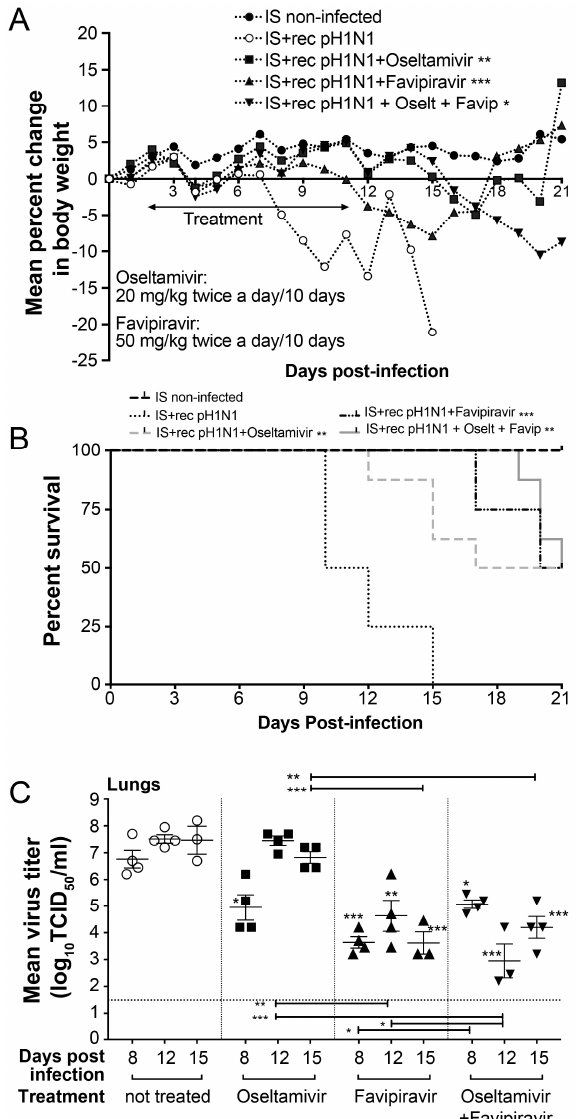
Figure 4. Evaluation of ten-day single and combined therapy with high dose of favipiravir in IS mice. C57BL/6 mice intranasally infected with 10 2 TCID 50 of rec A(H1N1)pdm09 received meglumine (placebo), 20 mg/kg of oseltamivir, 50 mg/kg of favipiravir or the combination by gavage BID for ten days, starting at 48 h post-infection (p.i.). An uninfected group (meglumine) was added as a control. ( A ) Animals were monitored daily for 21 days for clinical signs of illness, including weight loss, ruffled fur, and hunching and sacrificed when they lost 20% of their original body weight. ( B ) Kaplan–Meier survival curves for IS mice were compared using the Log-Rank (Mantel–Cox) test (** p < 0.01 and *** p < 0.001). ( C ) Lung viral titers ± standard error of mean were determined by TCID 50 using ST6-GalI-MDCK cells for groups of four mice euthanized on days 8, 12 and 15 post-infection and compared by one-way analysis of variance (ANOVA) with Tukey's multiple-comparison post-test (* p < 0.05, ** p < 0.01 and *** p < 0.001). The dotted horizontal line indicates the lower limit of detection, 10 1,5 TCID 50 /mL.